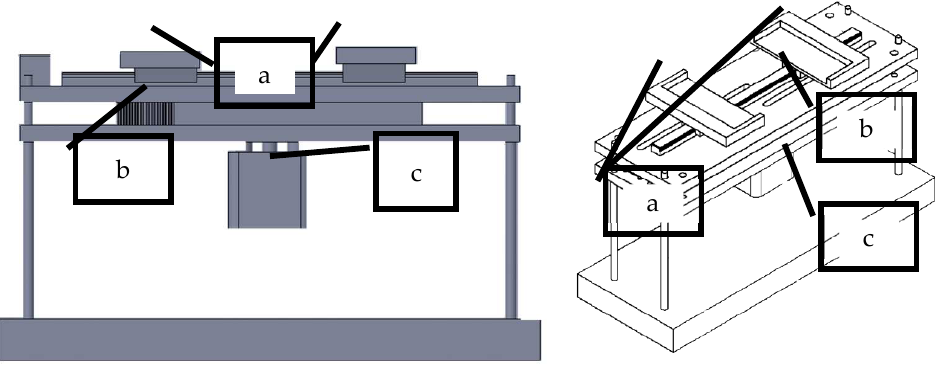
Figure 6. The mechanical device called SAHF-L: ( a ) sliding clamps; ( b ) cogged belt; ( c ) stepper motor.